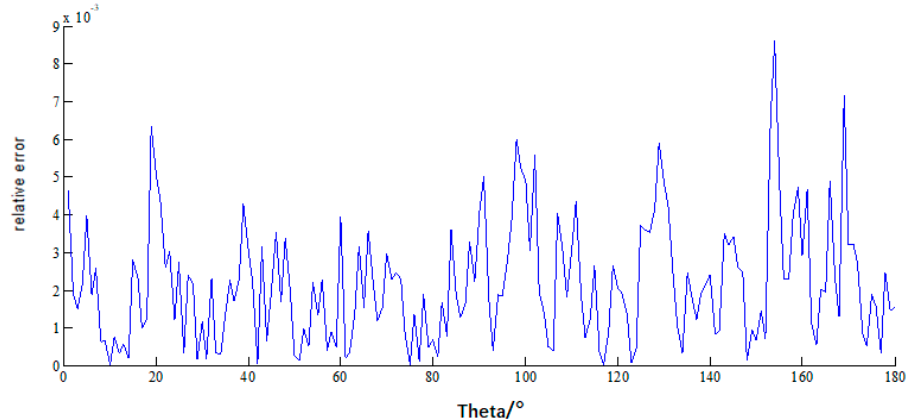
Figure 5. The relative error of the current of PEC cube by MLFMA and CS-MLFMA based on DCT basis.